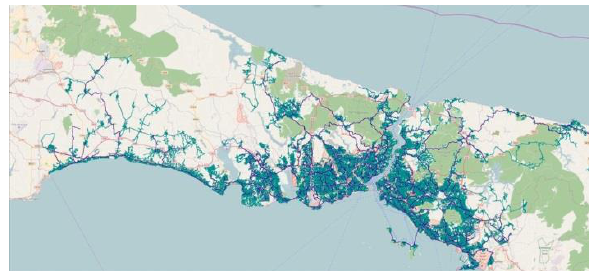
Figure 4. 3D underground utility